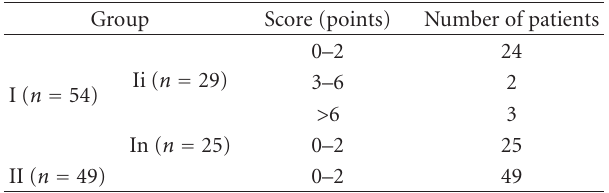
Table 5: Comparison of clinical signs of heart failure evaluated with the Reithmann’s pediatric heart failure